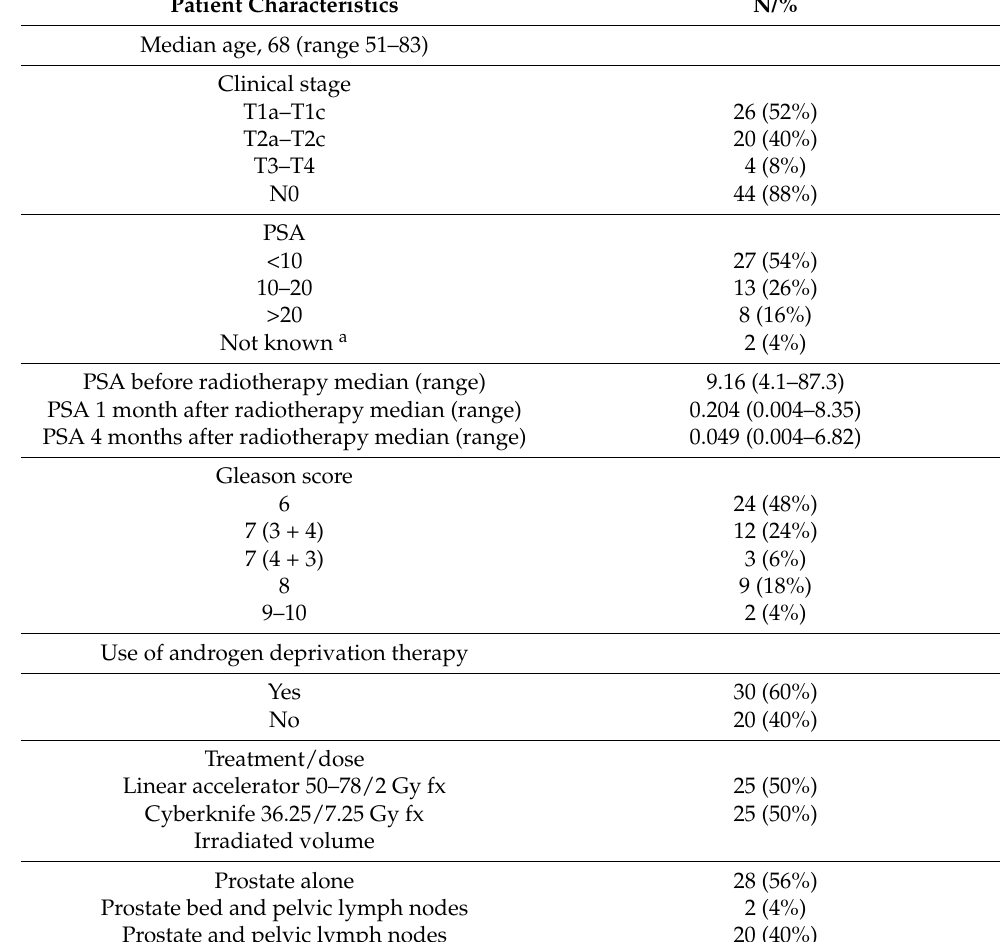
Table 1. Patient characteristics. a In two patients, we did not obtain information about the baseline PSA levels before hormonal therapy was introduced by the